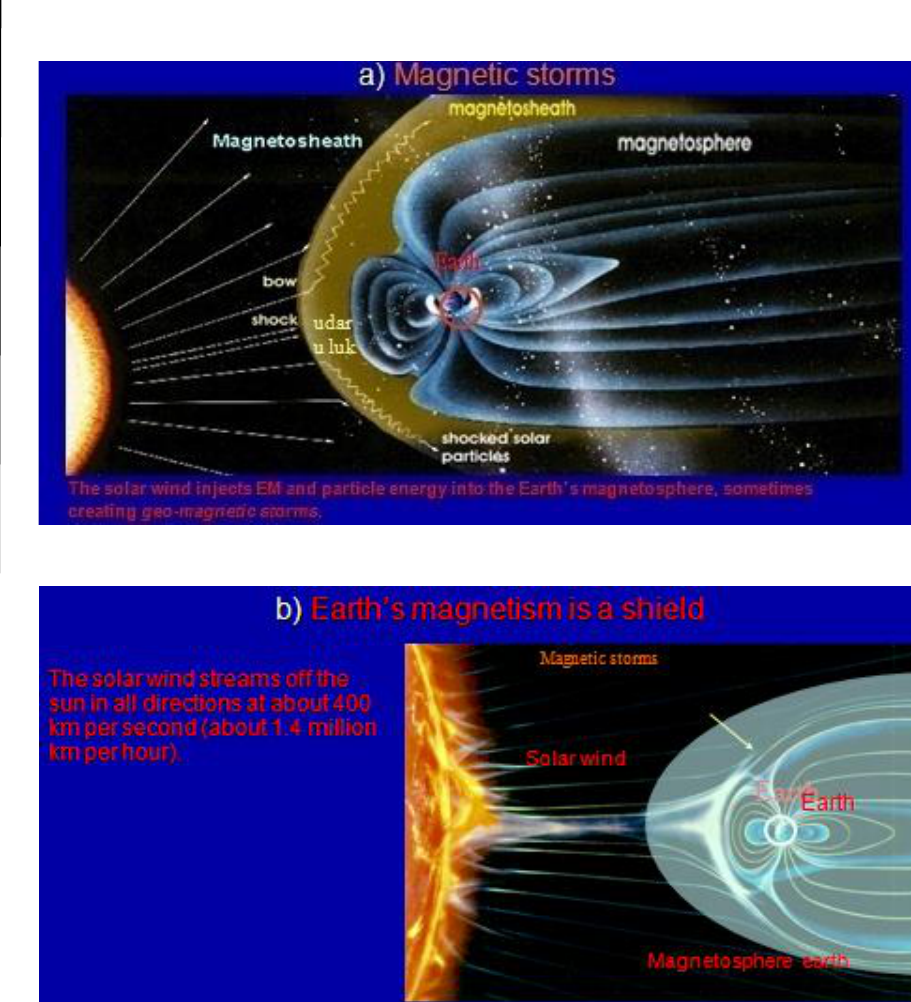
Figure 1 – a) Solar wind brings EM energy into the Earth's magnetosphere and creates geomagnetic storms, b) The Sun does not support permanent radiation